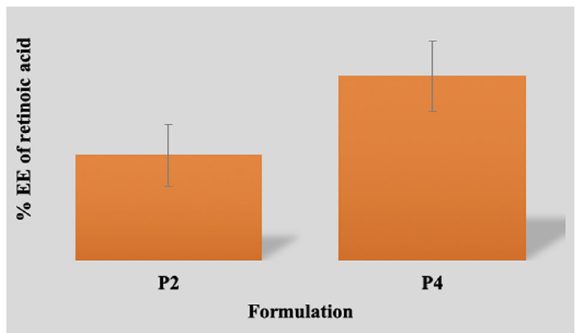
Fig. 1 % EE of retinoic acid-loaded polyplex formulations. Data were analysed using Student ’ s t test (* p < 0.05) when compared with polyplex formulation without pDNA